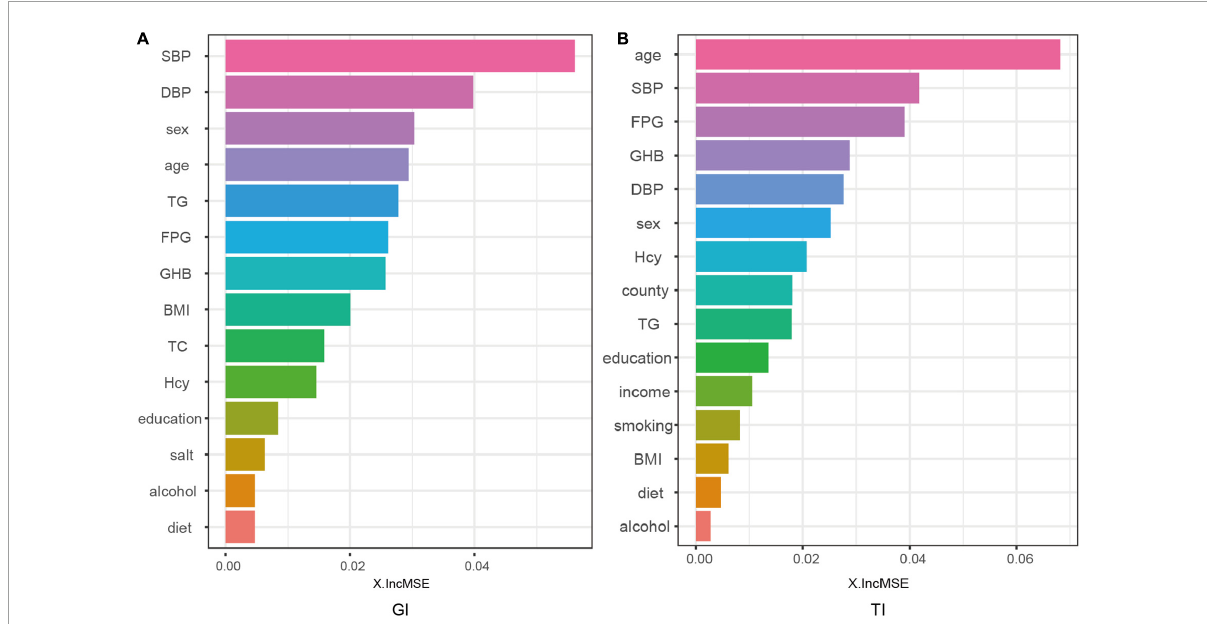
FIGURE5 Contributions of explanatory variables to the random forest model. The “%IncMSE” is the increase in mean squared error, where the error of the model prediction is increased by randomly replacing the value of each predictor variable if it is more important. Therefore, a larger value indicates that the variable is more important. (A) feature importances for GI; (B) feature importances for